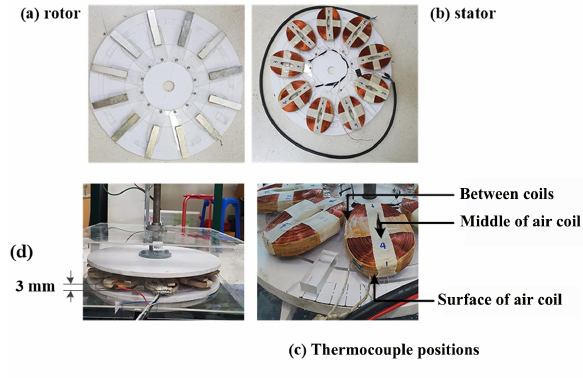
Fig. 1. (a) Twelve magnets installed on Bakelite plates for the rotor section. (b) Nine coils installed on Bakelite plates for the stator section. (c) Permanent magnet synchronous generator (PMSG) with a 3 mm air gap. (d) K-type thermocouple for temperature reading.